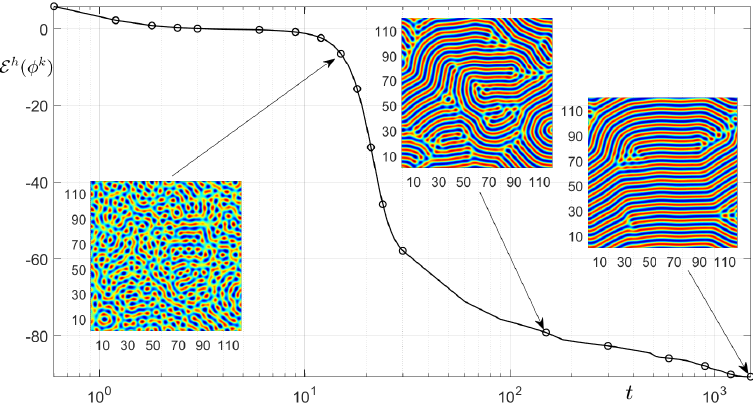
Figure 16. Energy dissipation over time of Equation (49) to the SH equation with the initial condition (47) . Note that t -axis is on